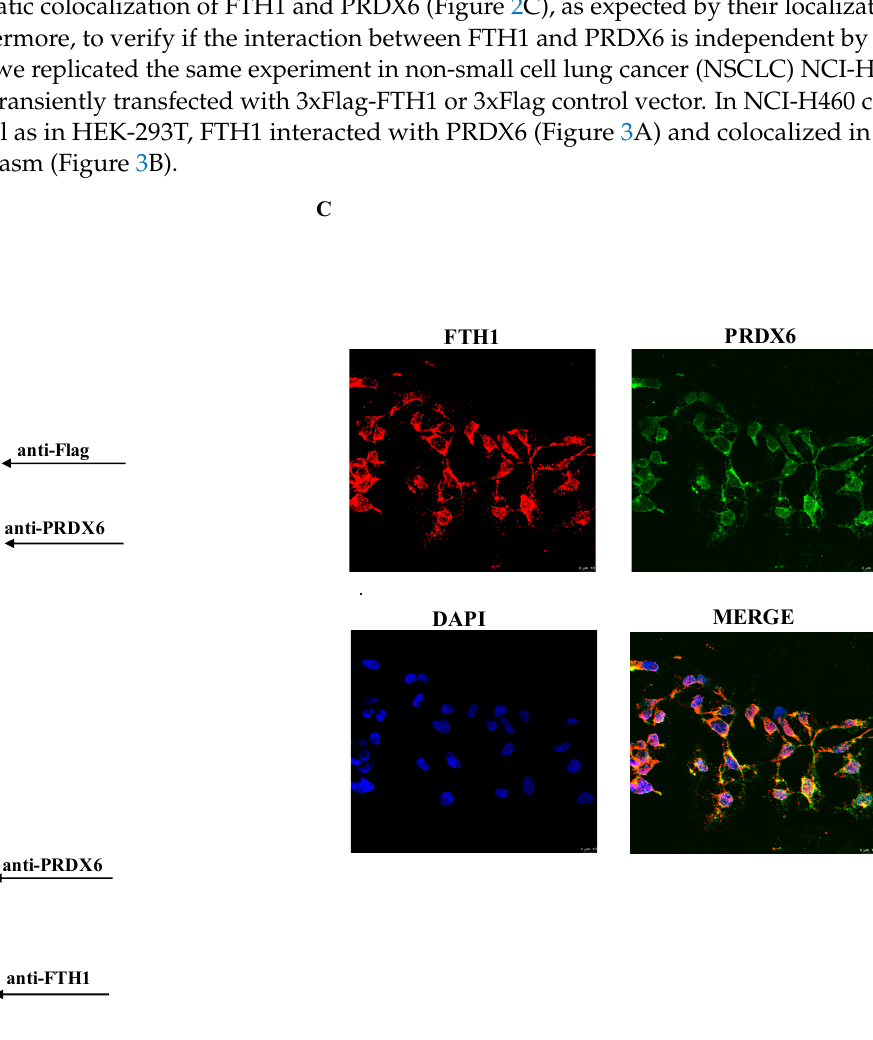
Figure 2. Co-IP and colocalization analysis of the interaction between FTH1 and PRDX6. ( A ) HEK-293T cells were transfected with Flag-FTH1 or a control vector (3x-Flag). Cell lysates were immunoprecipitated with anti-Flag M2 resin and then analyzed by immunoblotting with anti-PRDX6 and anti-Flag antibodies. ( B ) HEK-293T cell lysates were immunoprecipitated with FTH1 antibody or anti-mouse IgG, respectively. Eluates were analyzed by immunoblotting with anti-FTH1 or anti-PRDX6 antibodies. ( C ) HEK-293T cells were grown on a coverslip, fixed with 4% paraformaldehyde and processed for double-label immunofluorescence with anti-FTH1 antibody and anti-PRDX6 antibody. Images were collected using confocal microscopy system (40 × ). Representative data from one of three experiments.